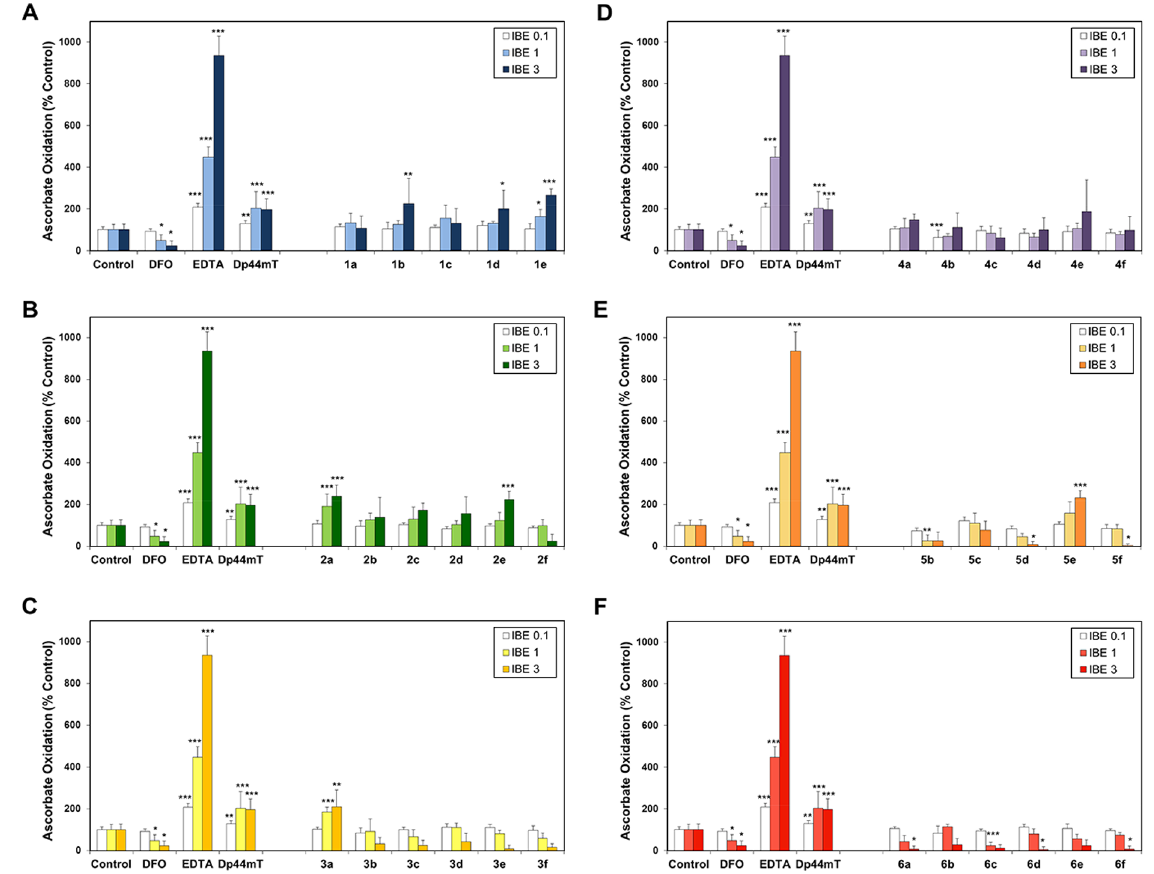
Figure 10. Effect of the iron complexes of (A) series 1, (B) series 2, (C) series 3, (D) series 4, (E) series 5 and (F) series 6 chelators, relative to DFO, Dp44mT and EDTA, on ascorbate oxidation. Chelators at iron-binding equivalent (IBE) ratios of 0.1, 1, and 3 were incubated in the presence of Fe III (10 m M) and ascorbate (100 m M). The UV-Vis absorbance at 265 nm was recorded after 10 and 40 min, and the difference between the time points was calculated. Results are mean 6 SD (3 experiments).